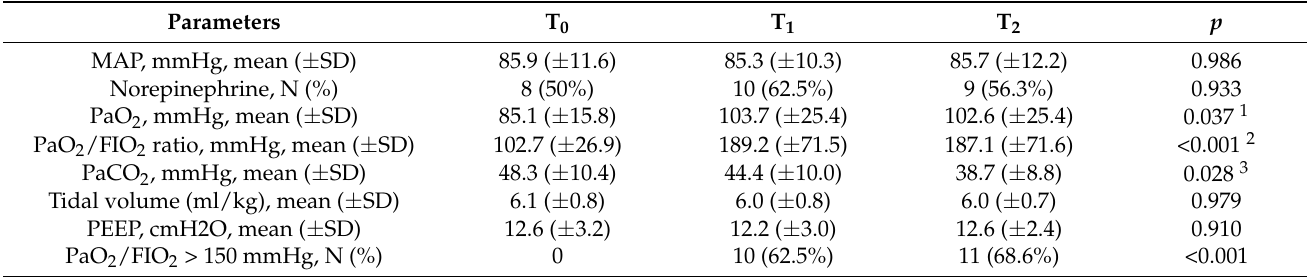
Table 3. Respiratory and hemodynamic responses to prone positioning ( n = 16).